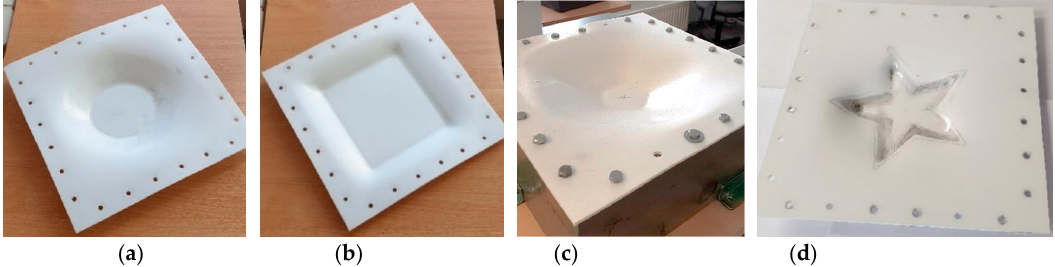
Figure 18. Photos of the incrementally formed polymer sheets of PVC ESA-D material was achieved by elevated temper- ature forming conditions: ( a ) spatial circular geometry; ( b ) spatial square geometry; ( c ) spatial flower geometry; ( d ) spatial star geometry.